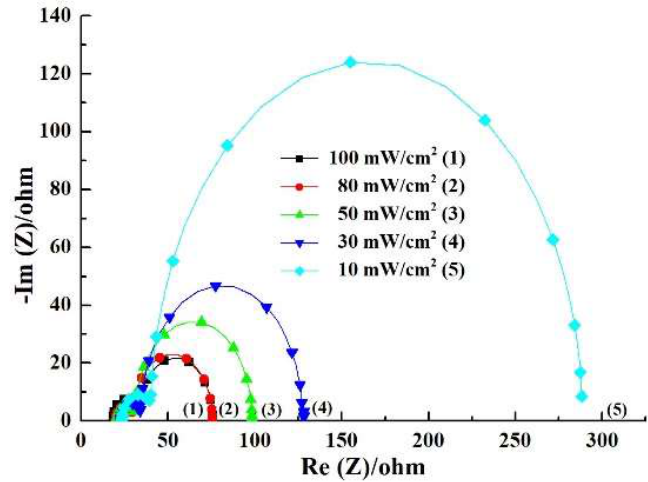
Figure 14. Nyquist plots for DSSCs based on TANP under different illuminations.